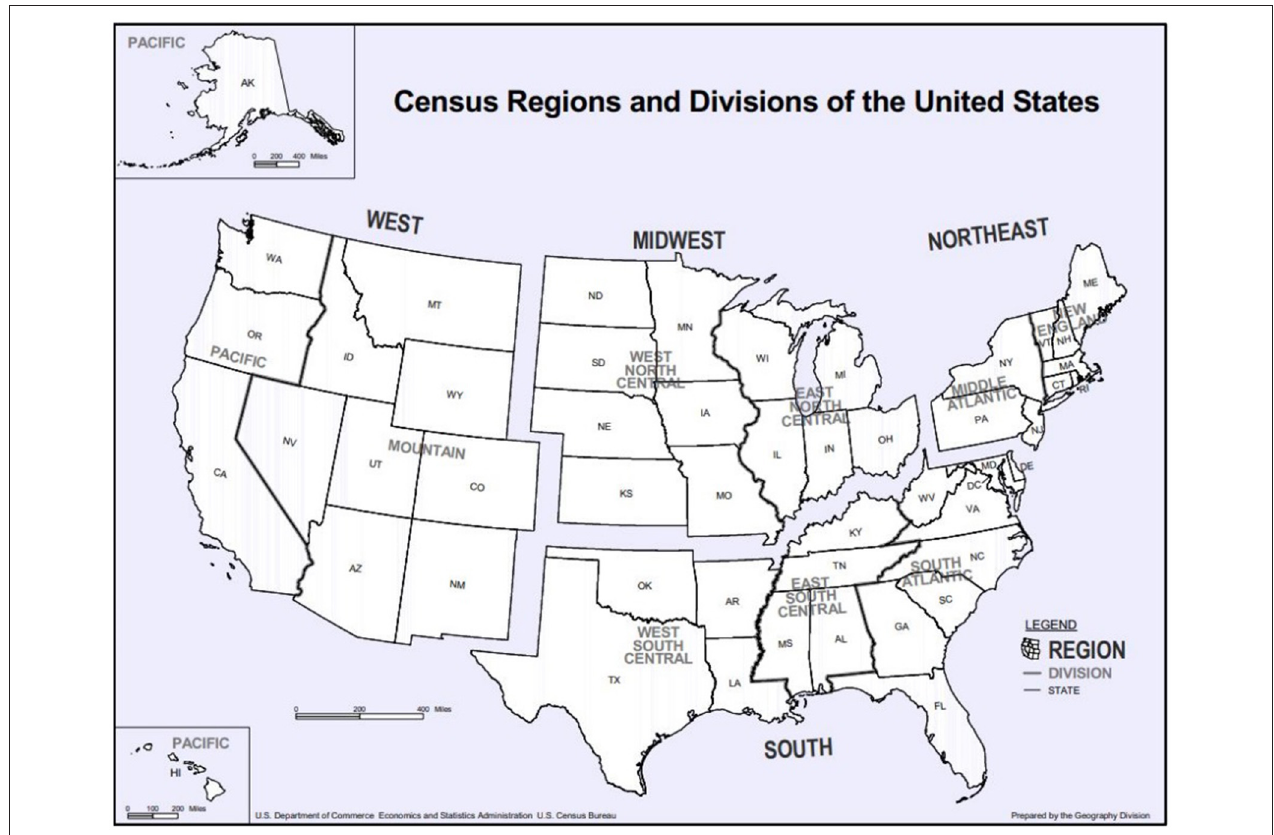
FIGURE 4 | U.S. Census Regions and Divisions of the U.S. Retrieved from U.S. Census Bureau, (2021). A written description is available in Kachan et al. (2014).